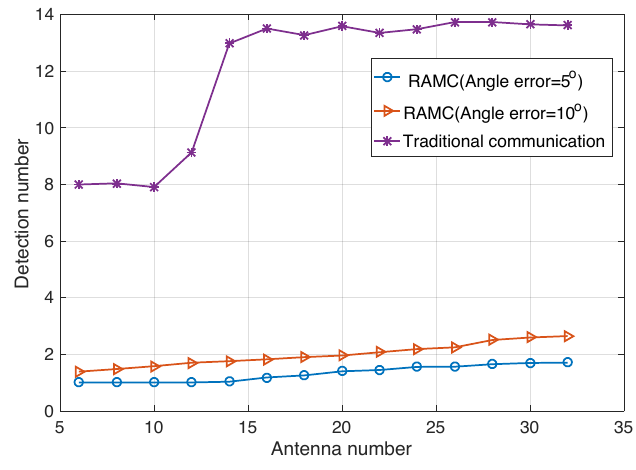
Figure 11. Cell discovery